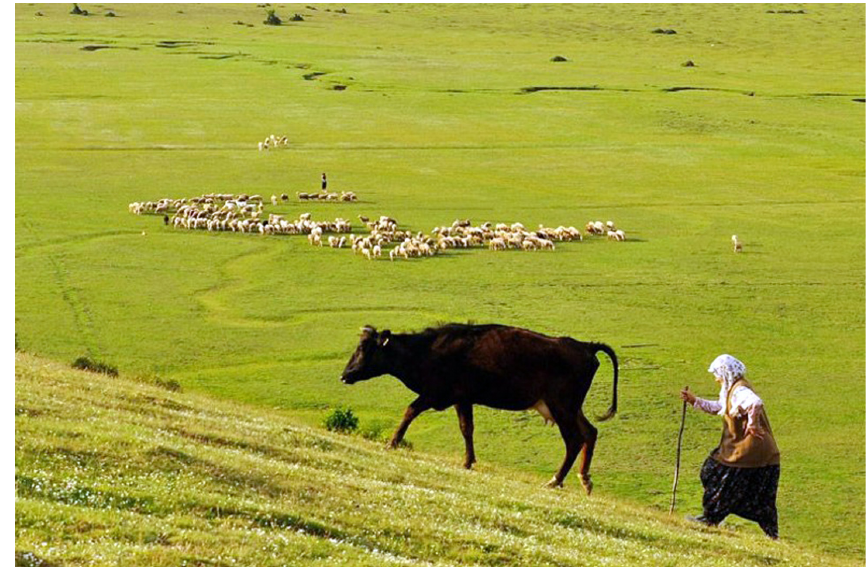
Fig. 2. Traditional livestock activities in the study area. Source: picture taken by